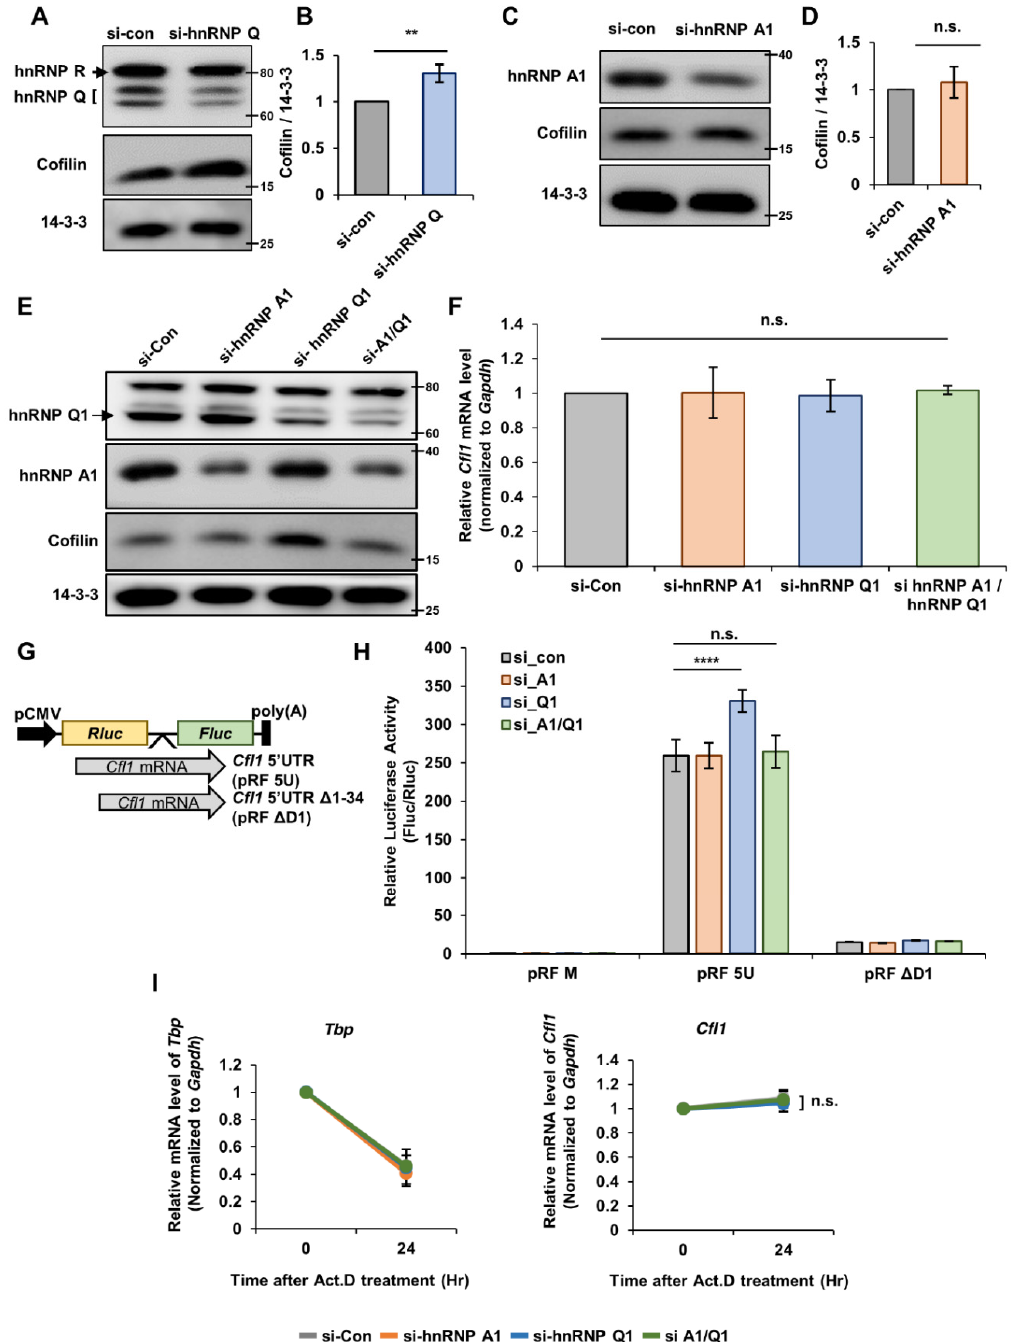
Figure 2. HnRNP Q and hnRNP A1 regulates the translational activity of Cfl1 mRNA. ( A , B ) Representative immunoblot ( A ) and quantification ( B ) of hnRNP Q knockdown experiment. N2a cells were transfected with si-control (left lane ( A ); gray ( B )) or si-hnRNP Q (right lane ( A ); blue ( B )). Immunoblot of 14-3-3 ζ was used for normalization. ImageJ was used to measure the intensity of the blot ( n = 3). ( C , D ) Representative immunoblot ( C ) and quantification ( D ) of hnRNP A1 knockdown experiment. N2a cells were transfected with si-control (left lane ( C ); gray ( D )) or si-hnRNP A1 (right lane ( C ); orange ( D )). 14-3-3 ζ was used for normalization. ImageJ was used to measure the intensity of the blot ( n = 3). ( E ) Representative immunoblot of double (hnRNP Q1 and hnRNP A1) knockdown experiment. N2a cells were transfected with si-control (first lane), si-hnRNP A1 (second lane), si-hnRNP Q1 (third lane), or both siRNAs (fourth lane). 14-3-3 ζ was used as a loading control. ( F ) RT-qPCR analysis of Cfl1 mRNA level in n2a cells transfected with si-control (gray), si-hnRNP A1